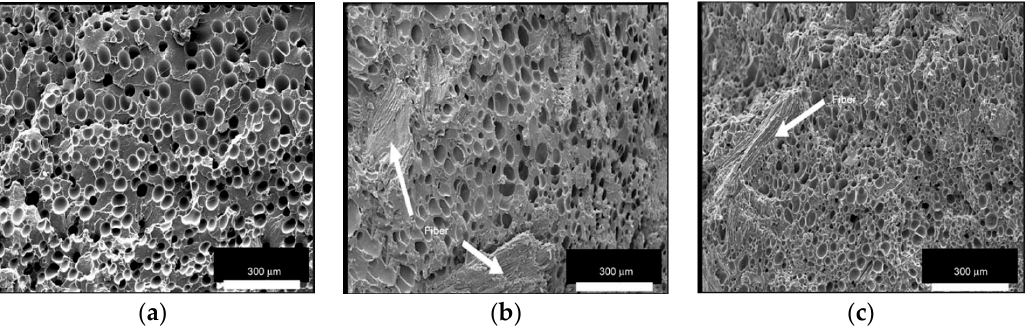
Figure 23. Scanning electron microscopy (SEM) image of foamed samples: ( a ) virgin PLA, ( b ) PLA/willow-fiber (80/20), and ( c ) PLA/willow-fiber (70/30). Reprinted from Zafar et al. [137]. With permission from Express Polymer Letters.